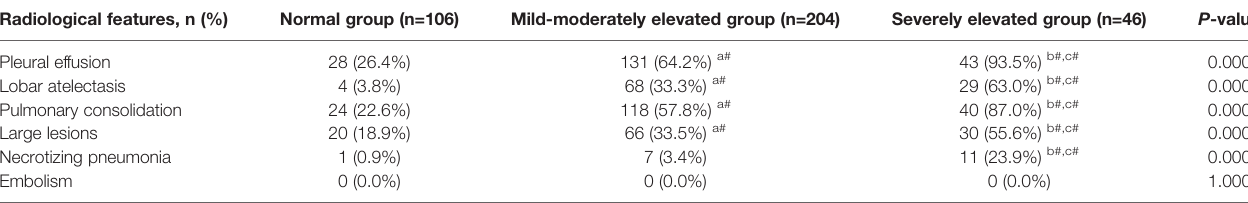
TABLE 3 | Radiographic features of patients with MPP. Radiological features, n